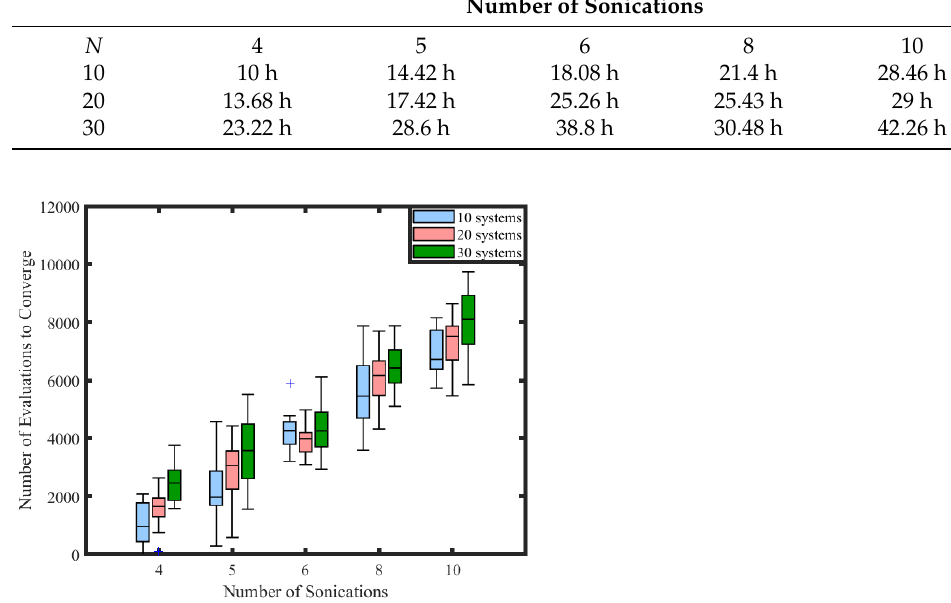
Figure 12. Number of evaluations to reach convergence for various numbers of sonications and systems.